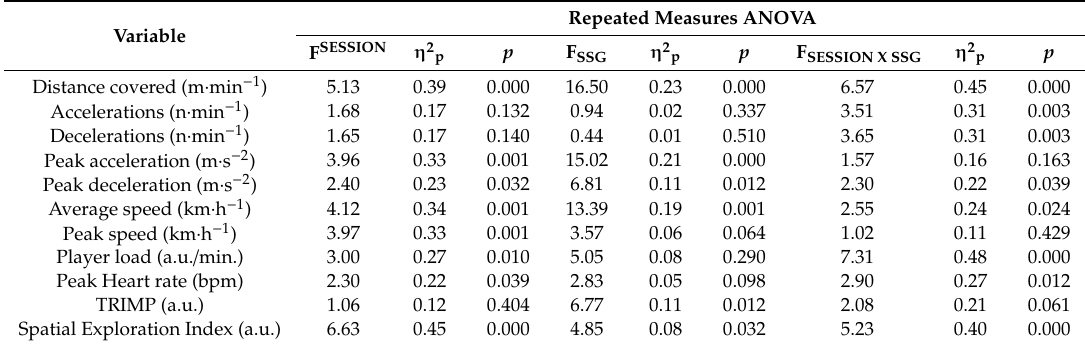
Table 1. Summary of the repeated measures analyses of the performance